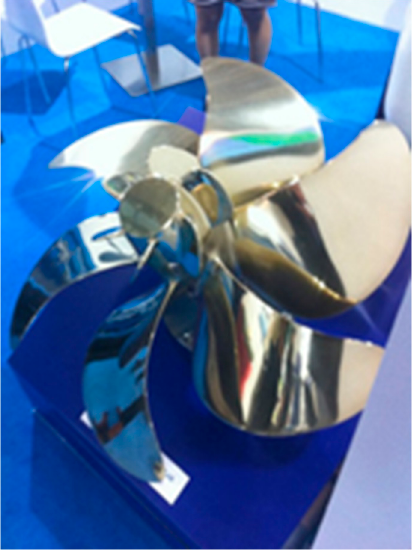
Figure 4. Post-swirl devices: PBCF